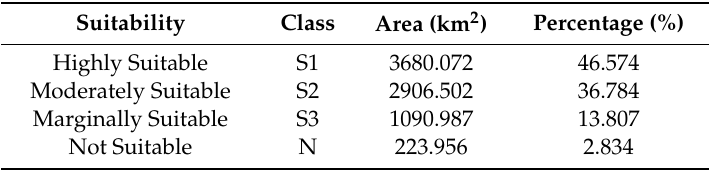
Table 7. Land suitability based on slope